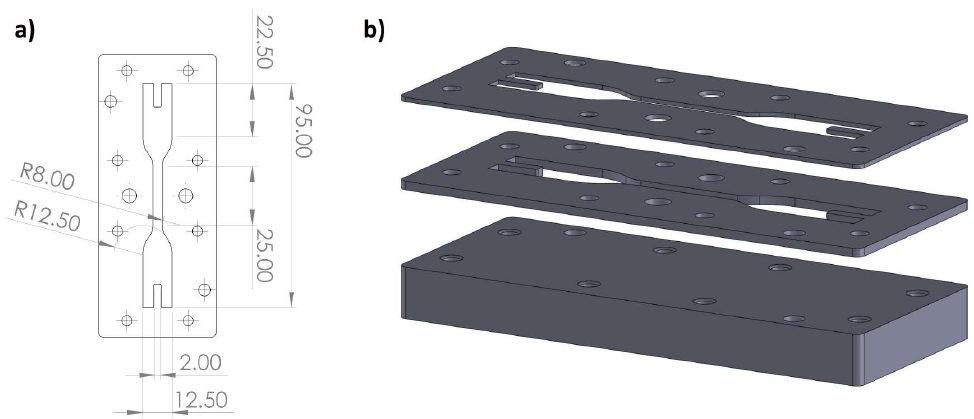
Figure 5. ( a ) Multilayer sample geometry (dimensions in mm); ( b ) exploded view of baseplate, 2 mm plate, and 1mm